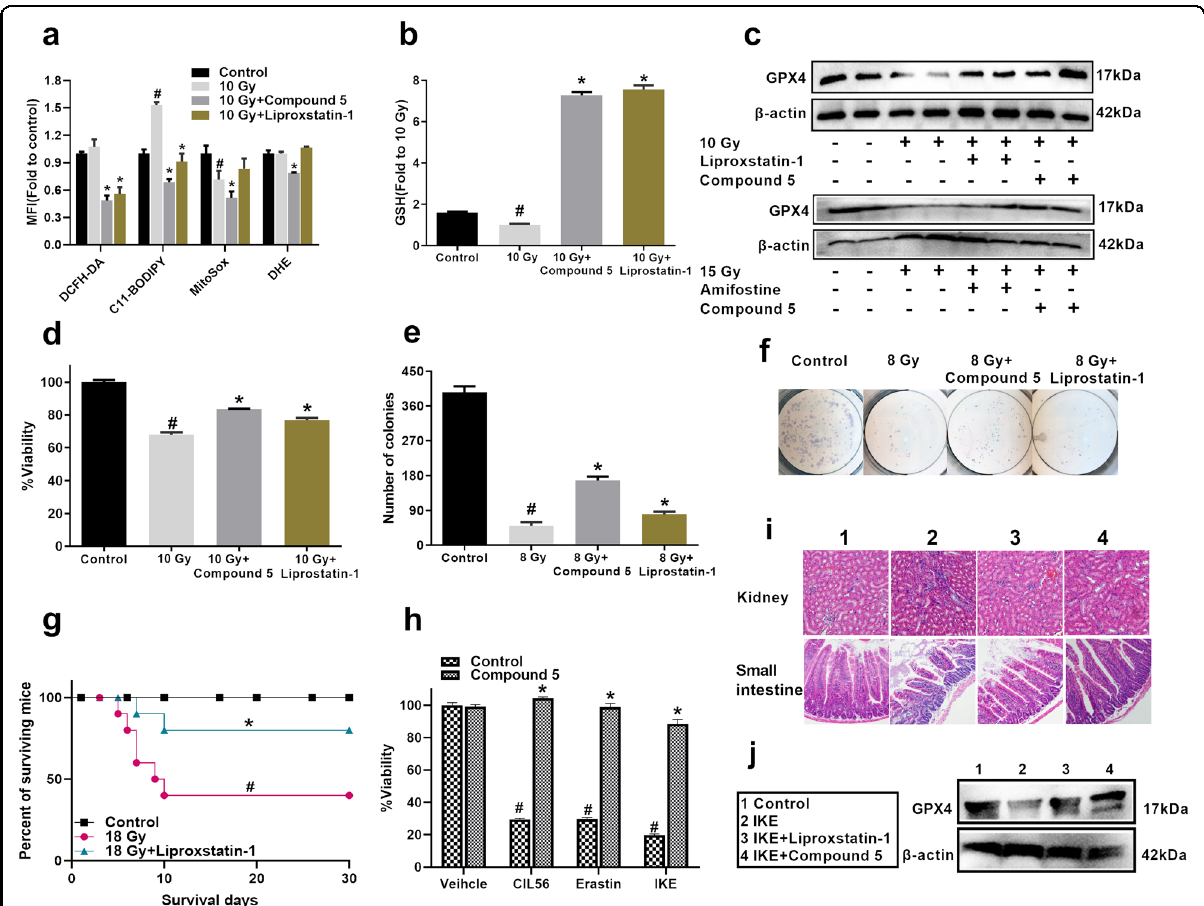
Fig. 8 Compound 5 inhibits IR and activator-induced ferroptosis. IEC6 cells were co-cultured with 100 μ M compound 5 or 50 nM liproxstatin-1 for 4 h (ROS and GSH experiments) or 24 h (survival experiment). a Cellular ROS level detected by DCFH-DA, C11-BODIPY, MitoSox, and DHE. b GSH level detected in IEC6 cells. c WB images showed expression of GPX4 protein in IEC6 cells (upper) and small intestine tissue (bottom). d Survival ratio of IEC6 cells after exposed to 10 Gy radiation. e Colony-forming number of IEC6 cells after exposed to 8 Gy radiation. f Representative images of colony forming. g Survival rate of mice exposed to 18 Gy ABI and treatment with 10 mg/kg liproxstatin-1 for 5 days. h Survival ratio of IEC6 cells after co-culture with ferroptosis activators. i HE images showed the morphology of small intestine and kidney after mice were administered with IKE. j WB images showed expression of GPX4 protein in small intestine crypts; # p < 0.05 vs Control, * p < 0.05 vs IR or relative ferroptosis inhibitors, N = 3 in a , N = 5 in b , N = 6 in d and f , N = 10 in e